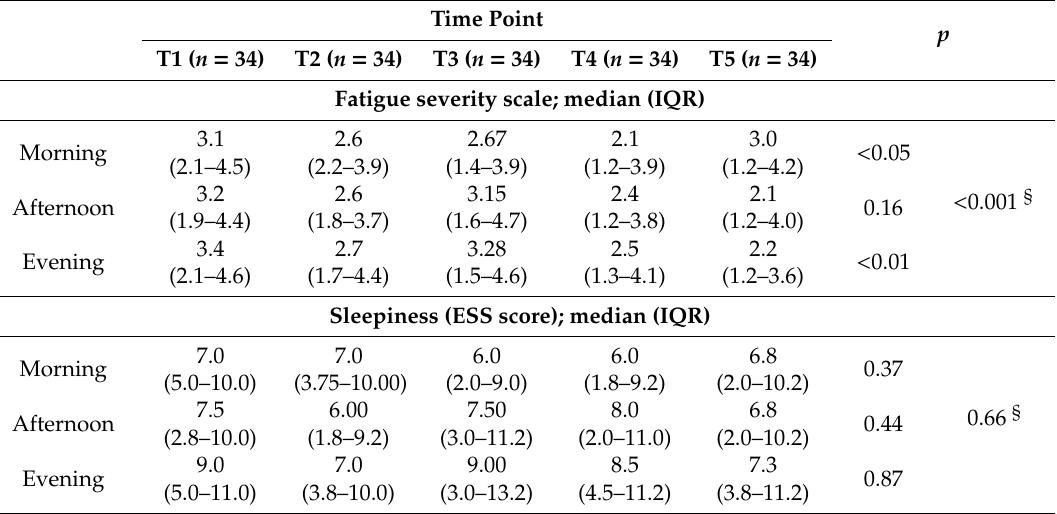
Table 3. Fatigue and sleepiness scores during RF (all participants).